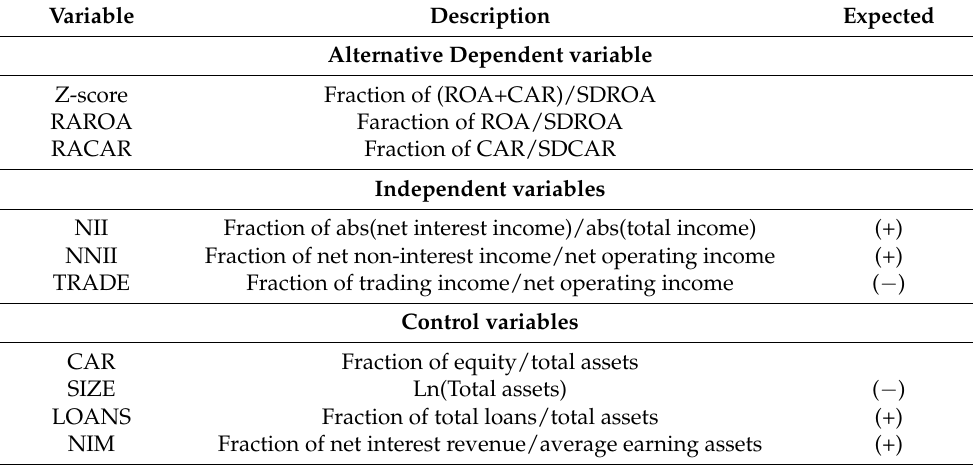
Table 1. The description of